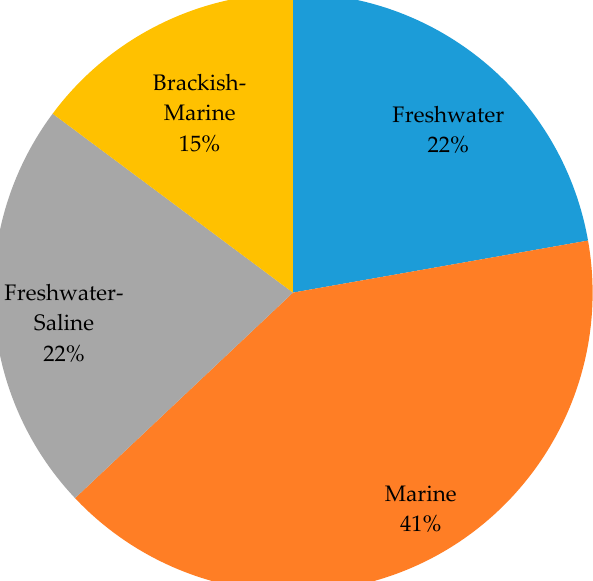
Figure 5. Environments of the potential IAS in the Baltic Sea (information of the environment of each species was based on WoRMS [28]). Saline means brackish or marine habitats. After the prioritization of species, we obtained four clear groups of species that shared the same probabilities of invasion (establishment, spread, and impact). The group sharing the highest probability of invasion contain eight species from different taxonomic groups: Plants (three species), Echinoderm (one species), Tunicata (one species), Crusta- cean (one species), Rhodophyta (one species), and Mollusk (one species). In general, fish species resulted to be less problematic, with low probabilities of invasion as compared to the other species (Table 4). Table 4. Prioritized list of species. The potential invasive species for the Baltic Sea are listed from highest to lowest probability of invasion. For each species, the scores (1–125) were obtained by multiplying the probabilities of establishment, spread, and impact. Probabilities are assigned based on previous information found in the literature and Global Invasive Species Database (GISD) [40] and Invasive Species Compendium (CABI) [26]. Different colors group species sharing the same scores.